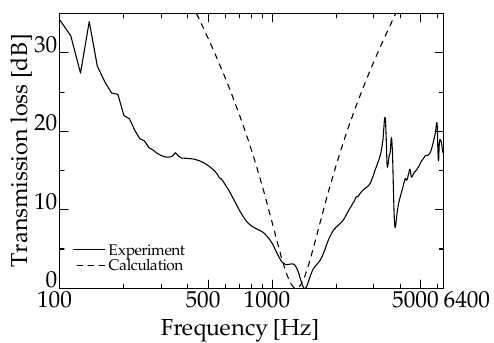
Figure 8. Transmission loss of single zero-mass metamaterial (experimental and theoretical).